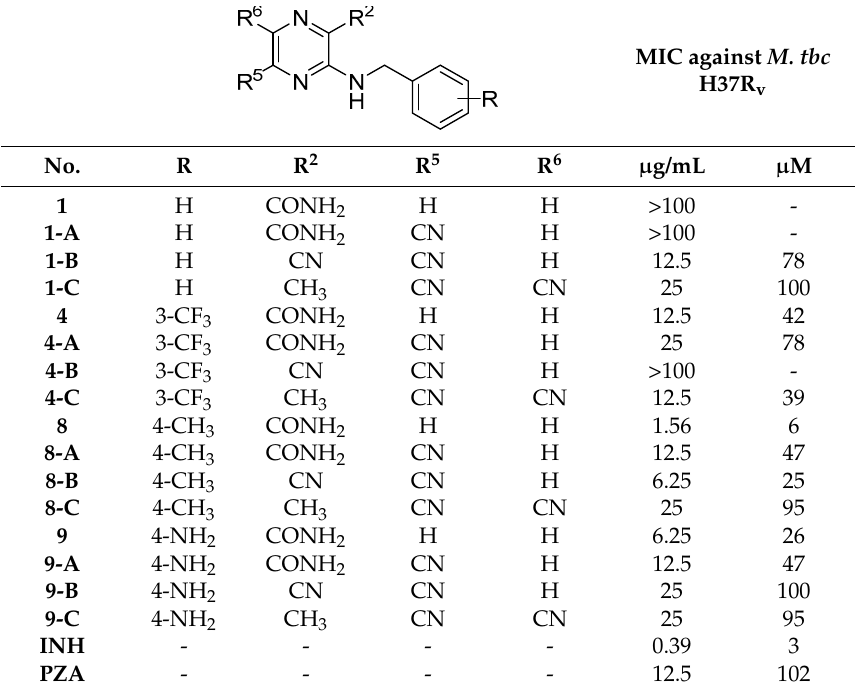
Table 2. Summary of prepared compounds, calculated and measured parameters of lipophilicity, results of antimycobacterial and antibacterial evaluation expressed as minimum inhibitory concentration (MIC) compared to standards.